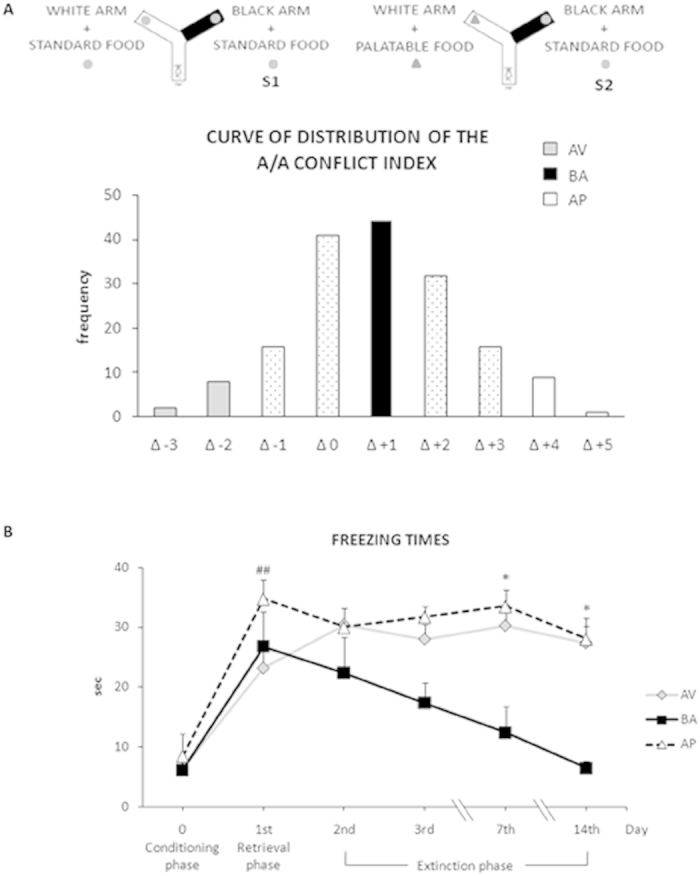
The Approach/Avoidance (A/A) conflict index permits to select the avoiding (AV) and approaching (AP) animals that do not extinguish middle-term fear memories, in comparison to balancing (BA) animals.(A) In the upper part of the Figure the A/A Y-Maze and its two sessions (S1: first session; S2: second session) are illustrated. A/A conflict index represents the difference (Δ) in the number of white choices between sessions. (B) Freezing times of AV, BA and AP phenotypes were similar in Conditioning and Retrieval phases, and they significantly increased between Conditioning and Retrieval phases (## at least P = 0.001). On day 14th the freezing times of AV and AP mice still did not significantly differ from those of Retrieval phase and were significantly higher than those of BA animals at day 7th and 14th (* at least P = 0.03). From day 7th on, the freezing times of BA mice were similar to those of Conditioning phase. Data are presented as means ± SEM.